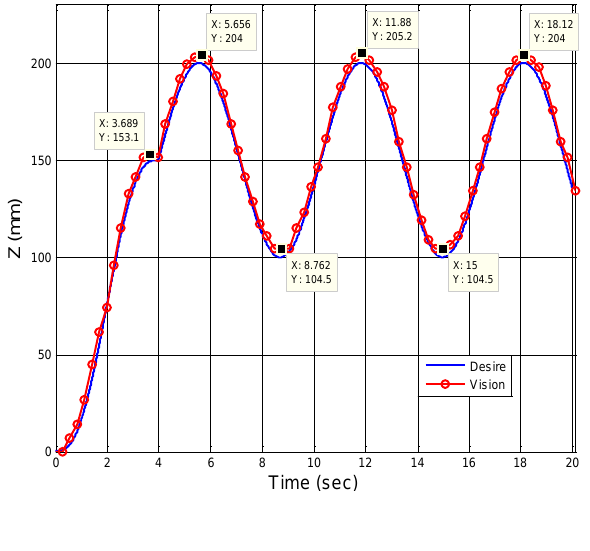
Figure 19. Comparison of the desired sinusoidal trajectory and the stereo vision measuring